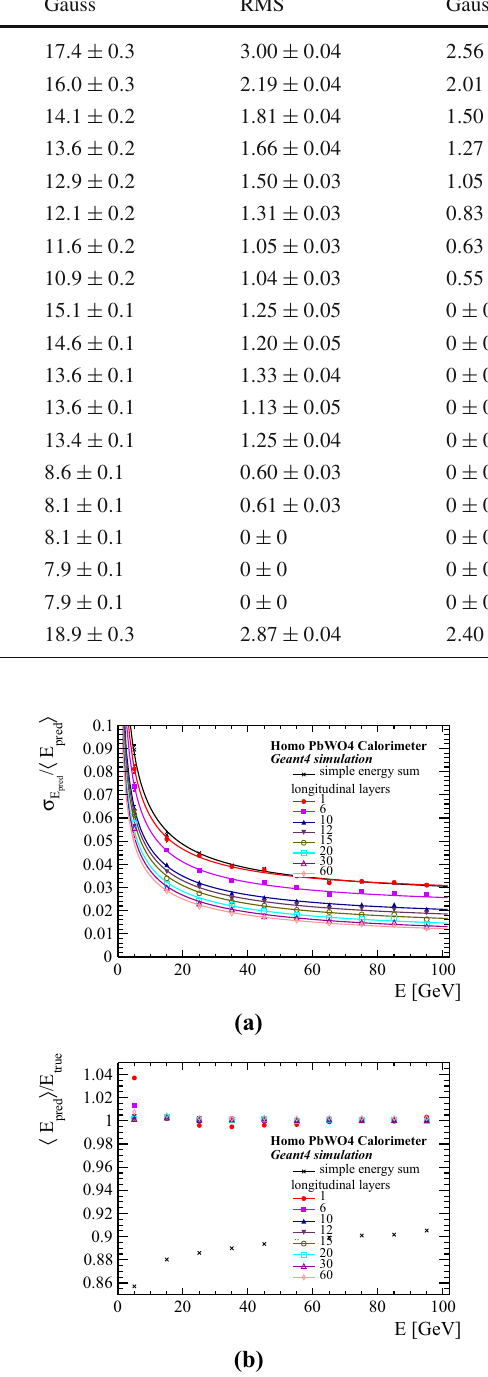
Fig. 2 Energy resolution ( a ) and linearity ( b ) for different longitudinal granularities and no transverse segmentation, compared to a simple energy sum. The curves correspond to the fit with Eq. (1)